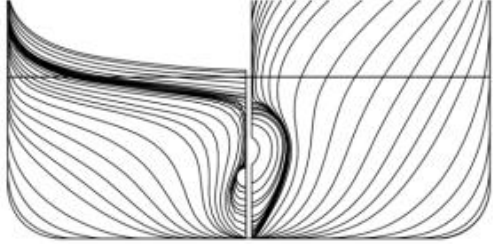
Figure 3. Body plan of a KRISO containership.